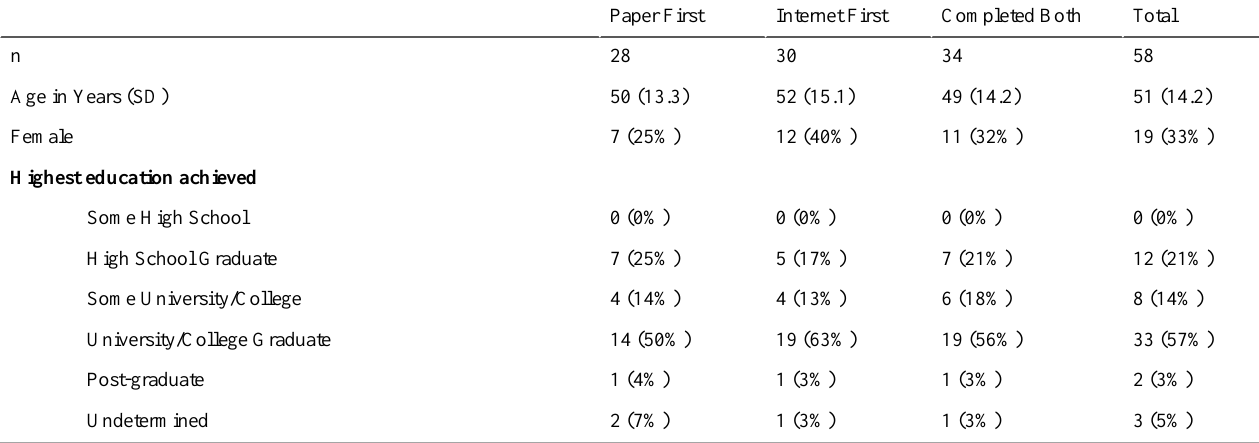
TotalCompleted BothInternet FirstPaper